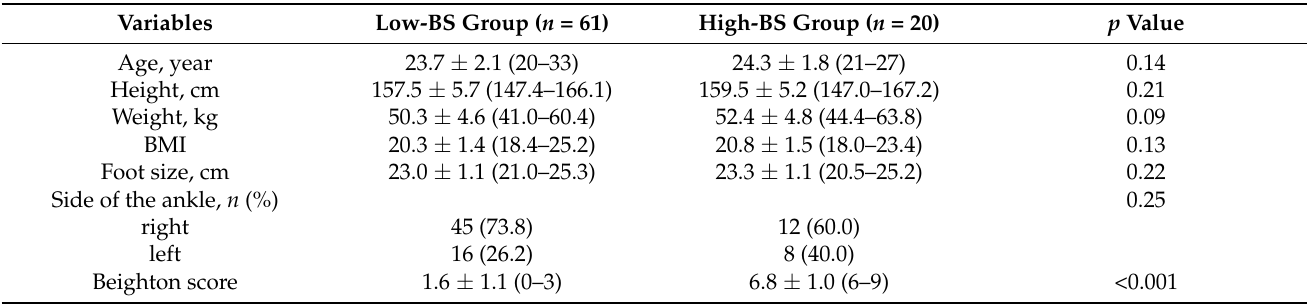
Table 1. Participant chracteristics of the two groups.